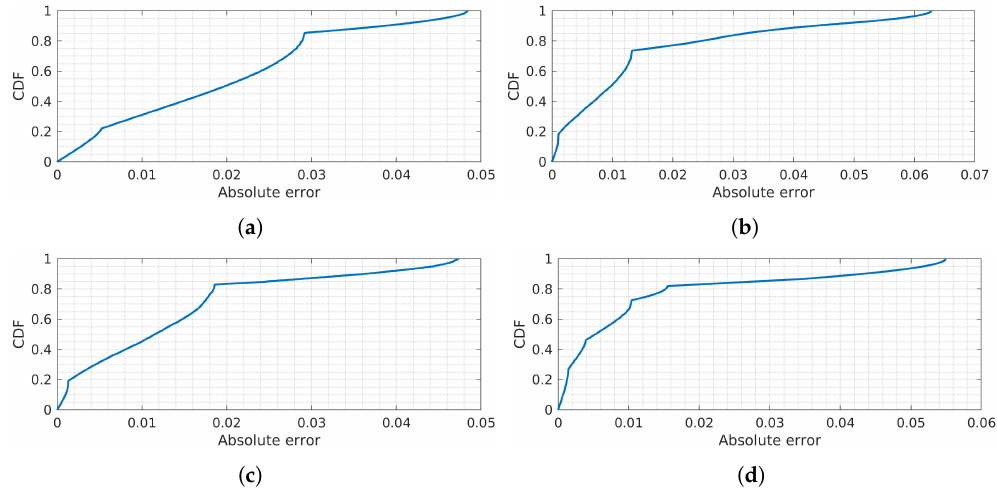
Figure 15. CDF’s for the absolute errors at different orbit configurations and ES’s as in Figure 10a–d. Absolute error CDF’s for: ( a ) φ ES = 30 ◦ and i SAT = 30 ◦ at h k = 1000 km; ( b ) φ ES = 45 ◦ and i SAT = 65 ◦ at h k = 1000 km; ( c ) φ ES = 20 ◦ and i SAT = 75 ◦ at h k = 1000 km; ( d ) φ ES = 85 ◦ and i SAT = 85 ◦ at h k = 1000 km.